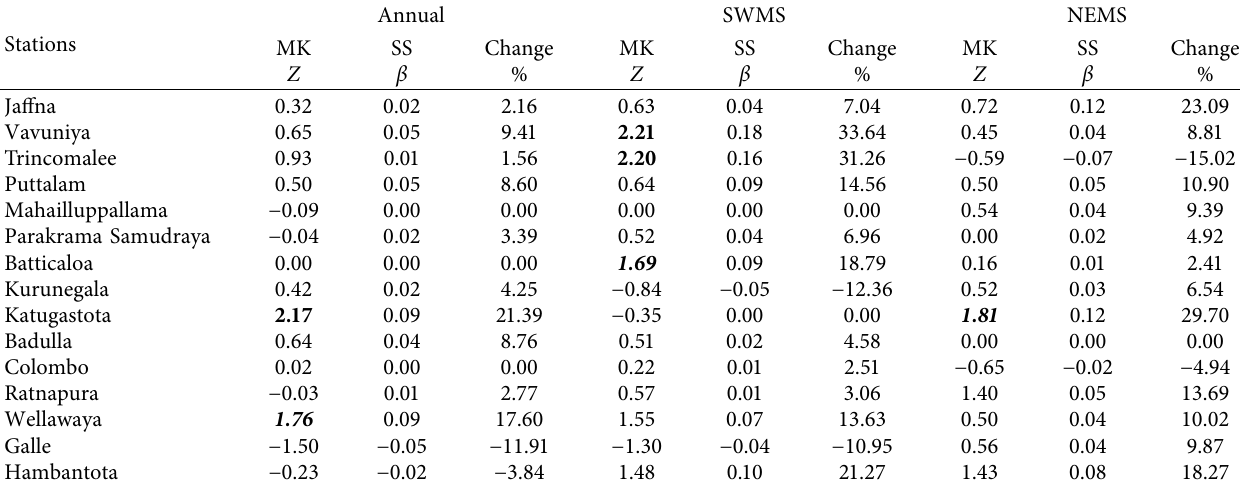
Table 6: Result of trends and percent change in PCI during